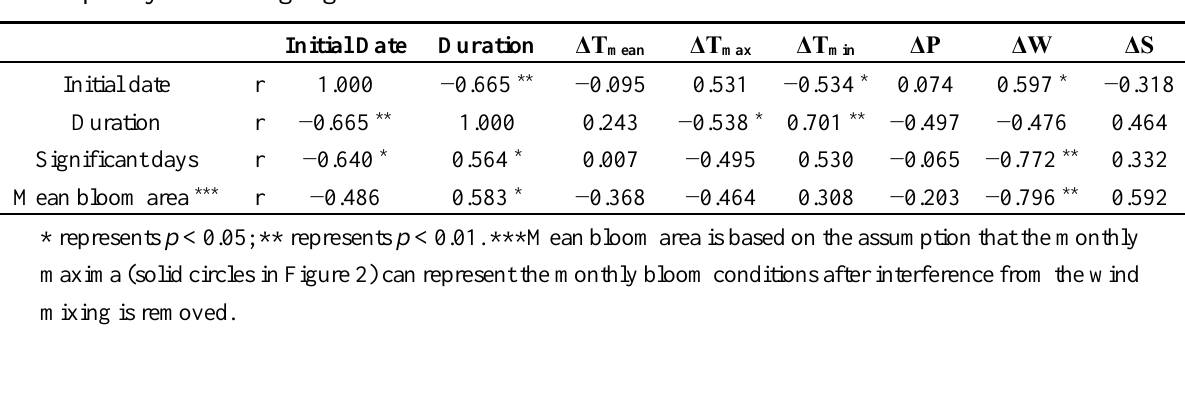
Figure 8. Trend in daily average anomalies of mean ( a ), maximum ( b ), and minimum ( c ) temperatures; precipitation ( d ); wind speed ( e ); and sunshine hours ( f ) during the period 2000–2013 for Lake Taihu. The line shows the linear regression against year. Table 4. Relationship between initial bloom date, duration, bloom significant days, and frequency of floating algae blooms in Lake Chaohu and climate variables.